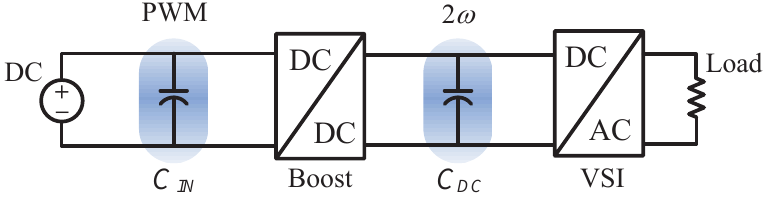
Figure 2. Two stage converter decoupling